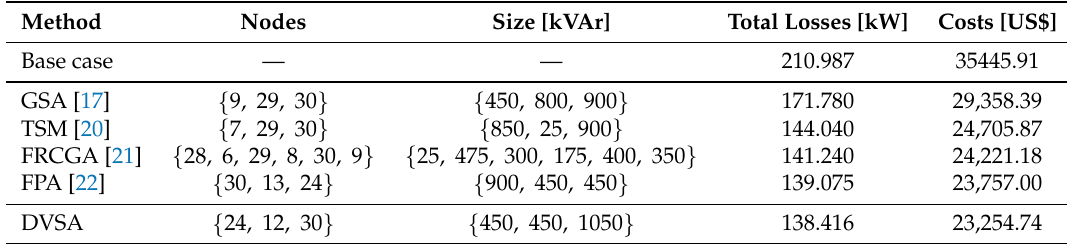
Table 3. Optimal location of capacitor banks in the 33-node test feeder.